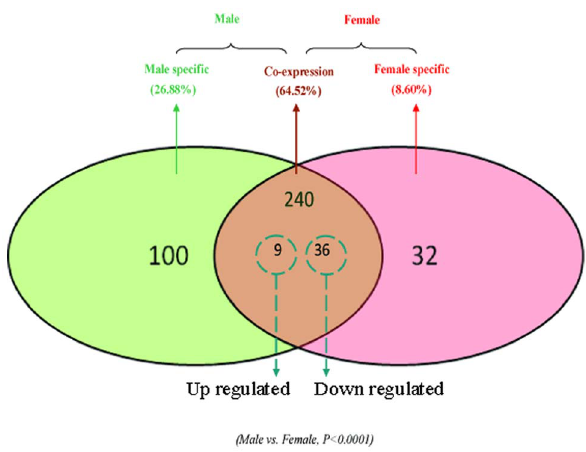
Figure 4. Comparison of miRNAs between the female and male E.sinensis . The Venn diagram displays the distribution of 372 unique miRNAs between the male (left, green circle) and female (right, pink circle) libraries. The dashed circles indicate the miRNAs that were significantly differentially expressed (p , 0.0001, Bonferroni corrected) in the two